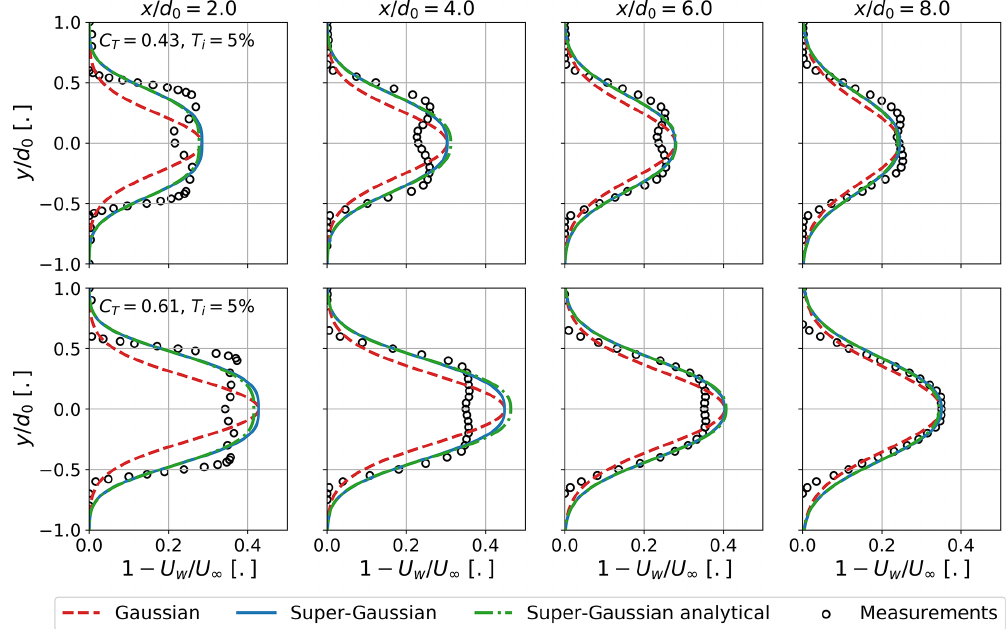
Figure 3. Normalized velocity deficit at four axial distances behind the actuator disk. Low-turbulence